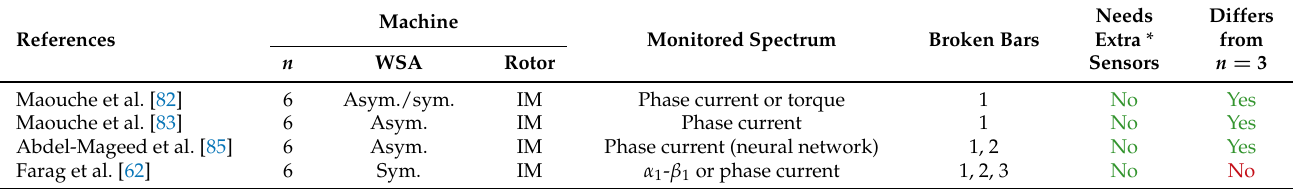
Table 28. Methods for detecting broken bars (Section 12.6.2) in multiphase applications in the literature.